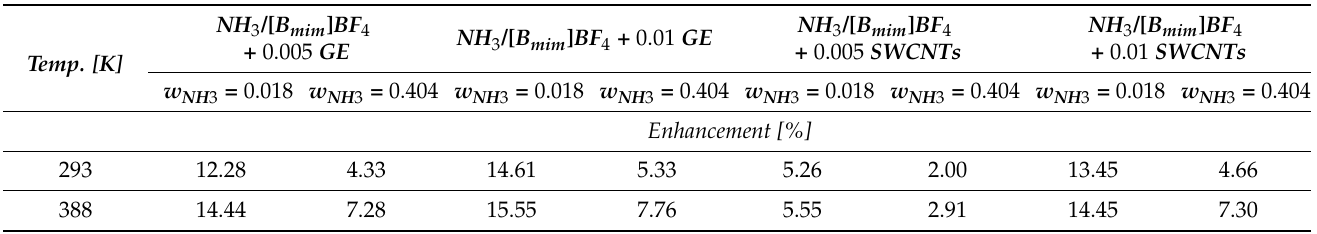
Table 2. Enhancements in thermal